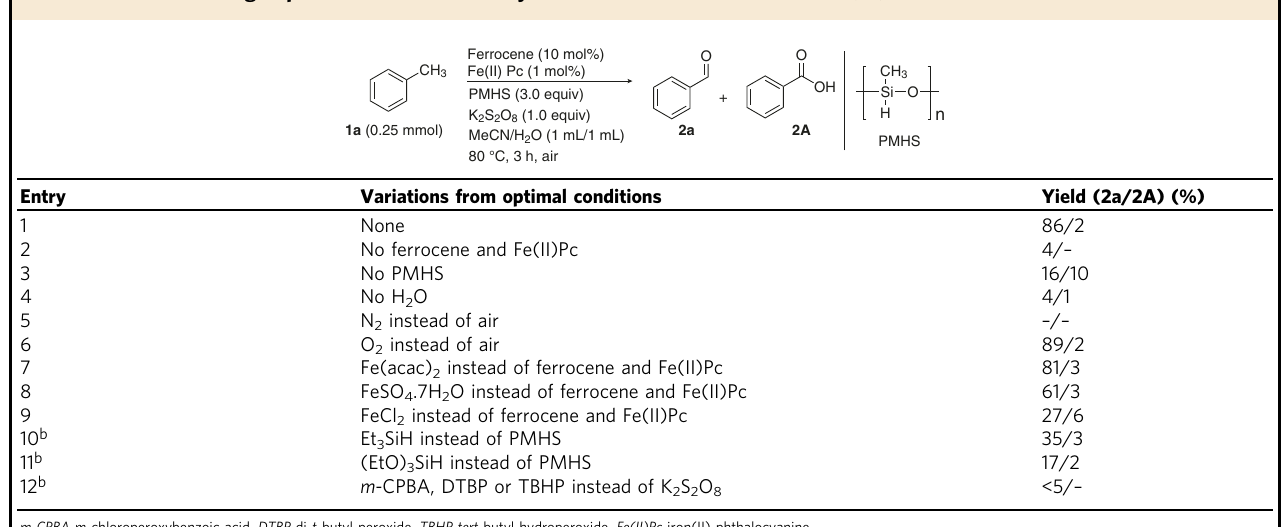
Table 1 Select screening experiments for iron-catalyzed aerobic oxidation of toluene (1a) a